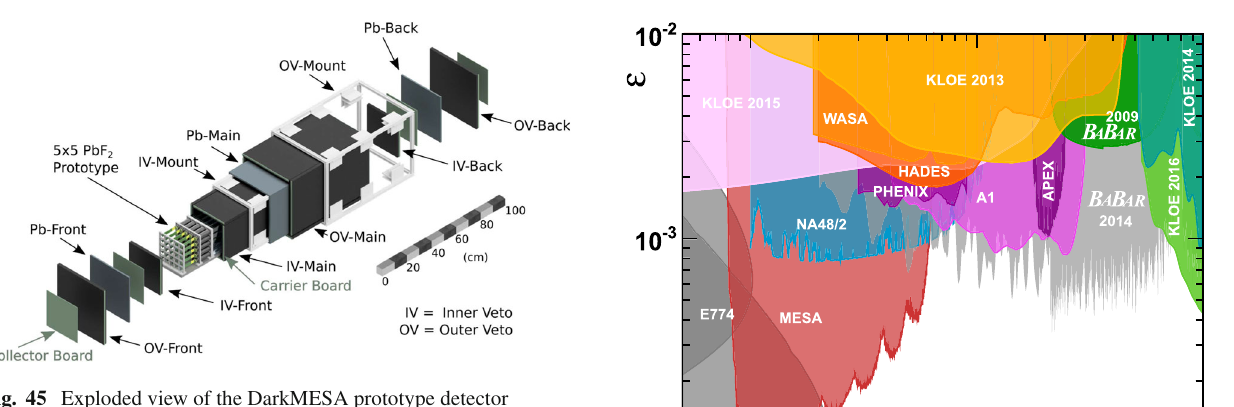
Fig. 45 Exploded view of the DarkMESA prototype detector